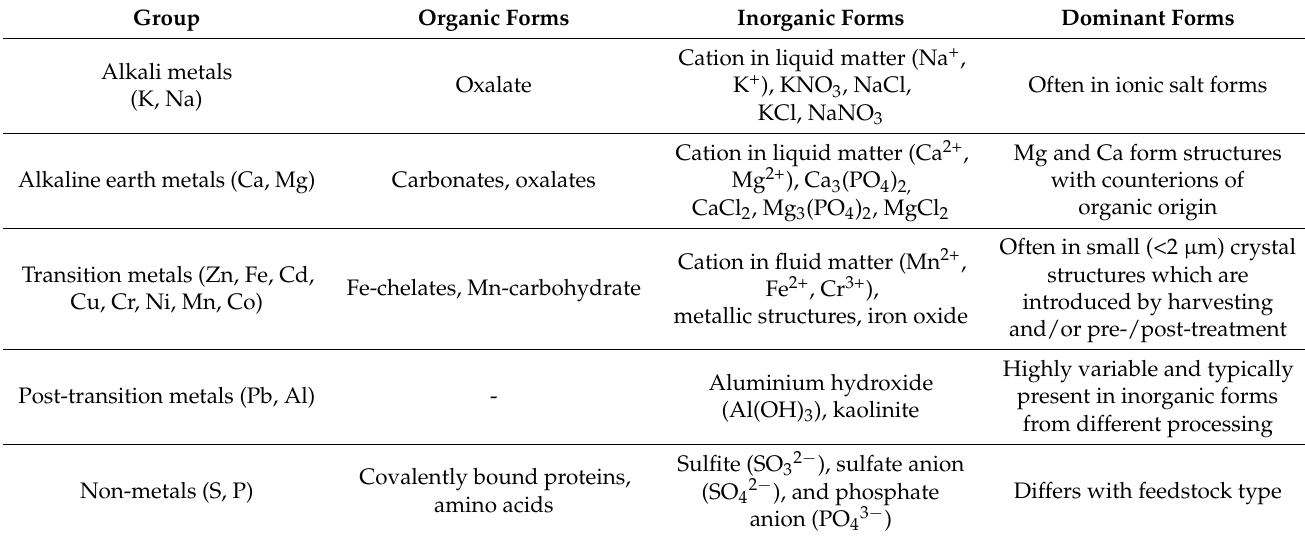
Table 1. Different forms of inorganic existence in lignocellulosic biomass